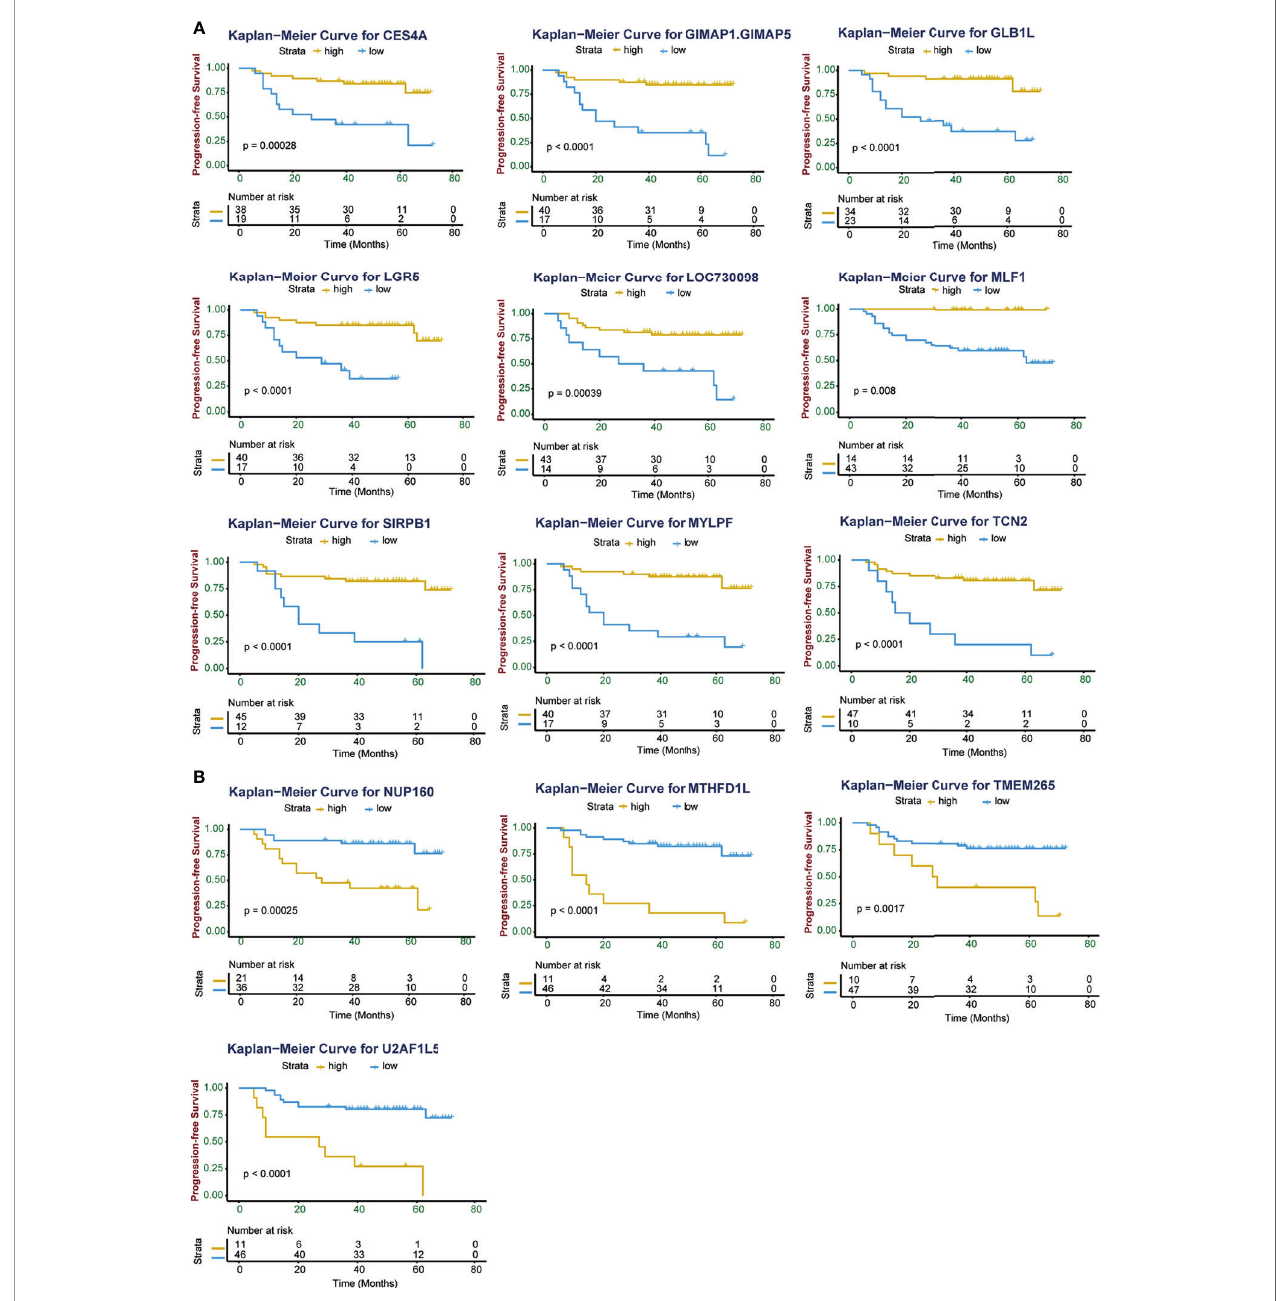
FIGURE 2 | Kaplan-Meier curves of progression-free survival (PFS) for high and low expression of the 13 signi fi cant genes in NPC patients. (A) High expression level of the genes CES4A, GIMAP1-GIMAP5, GLB1L, LGR5, LOC730098, MLF1, SIRPB1, MYLPF, and TCN2 were associated with improved PFS in patients with NPC. (B) High expression levels of the genes NUP160, MTHFD1L, TMEM265, and U2AF1L5 were associated with poor PFS in patients with NPC. The Kaplan-Meier p values are